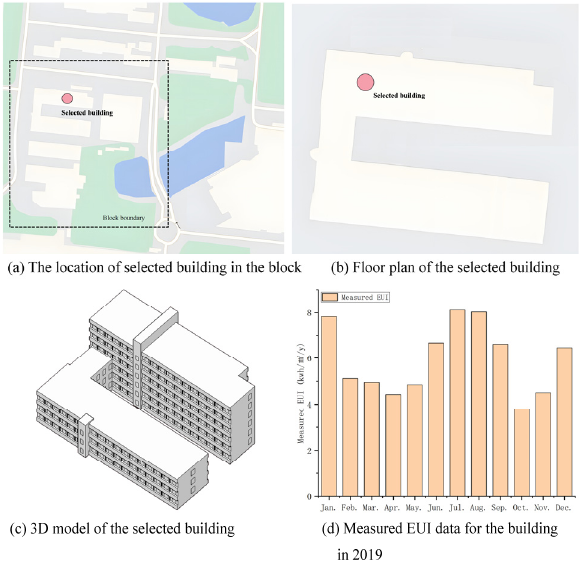
Figure 9. Building information and monthly electricity consumption data.